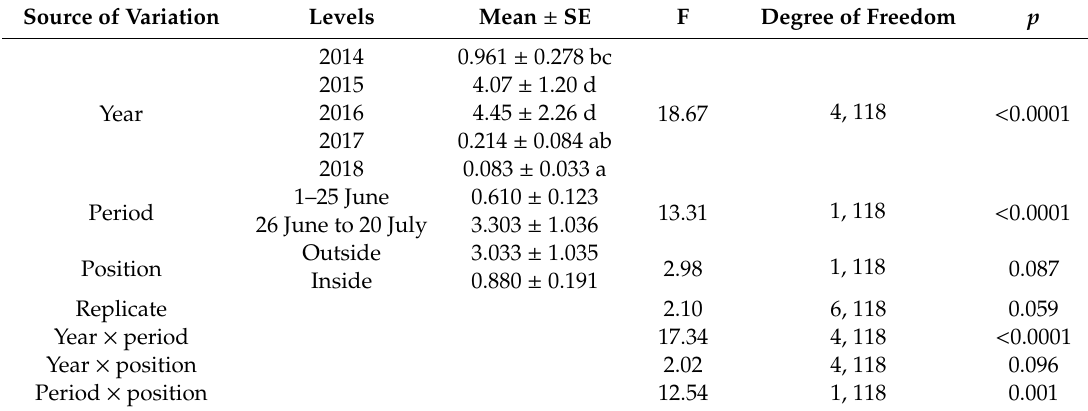
Table 2. Captures of Hyalesthes obsoletus recorded from 2014 to 2018 in vineyard B habitat. Source of Variation